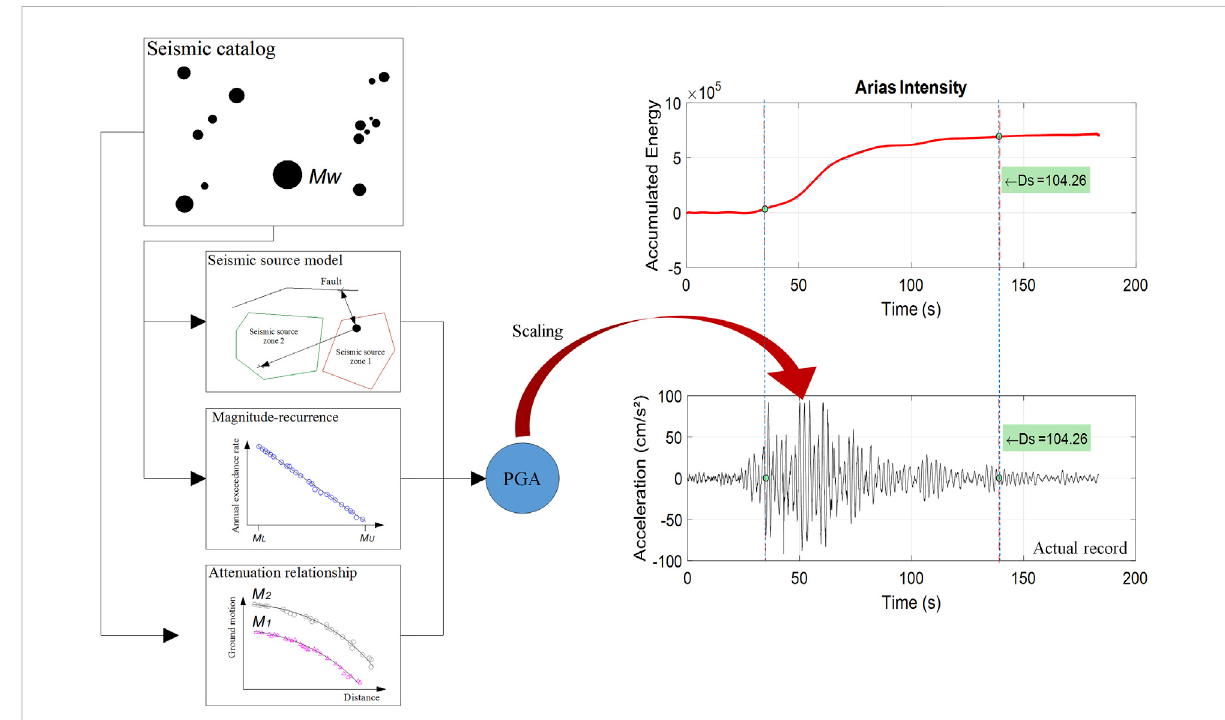
FIGURE 2 Illustration of the characterization of seismic records used in the